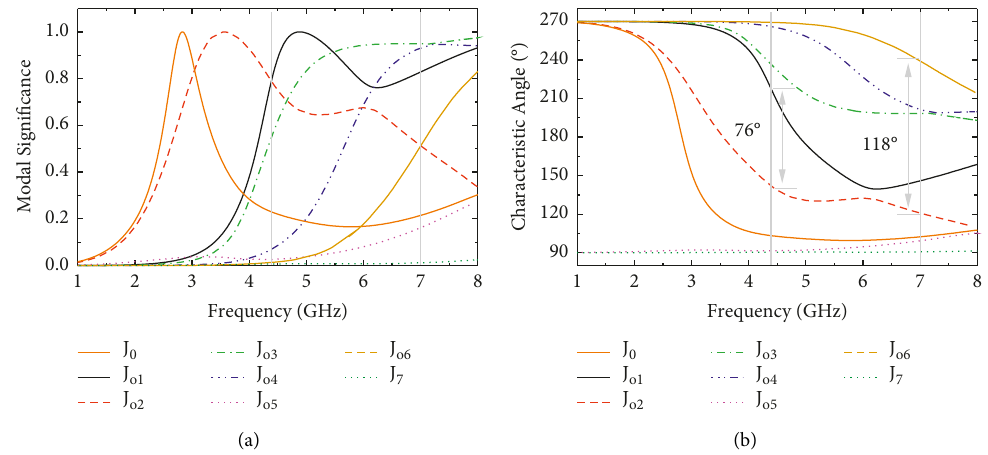
Figure 9: (a) Modal significance and (b) characteristic angle for the first eight modes of Proto B calculated at 4GHz.